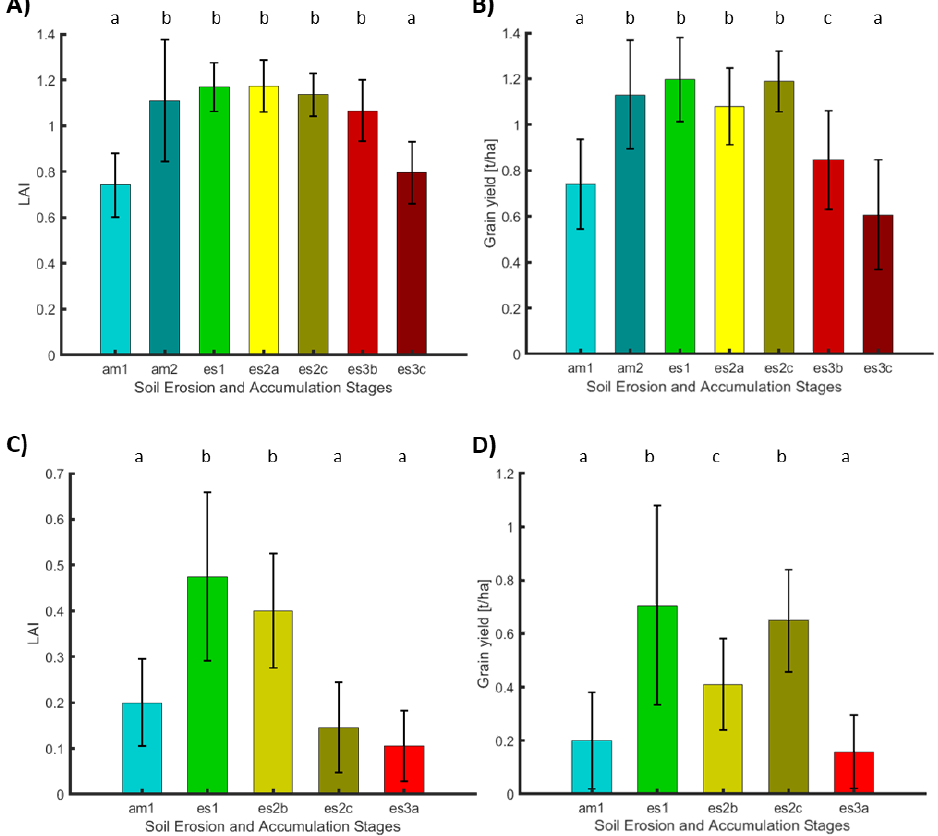
Figure 11. Median plots of biophysical parameters grouped across SEAS for field site SU (top row): ( A ) LAI and ( B ) grain yield, and field site E1 (second row): ( C ) LAI and ( D ) grain yield. Different letters on top of bars indicate significant statistical differences of parameters at 5% probability level between SEAS and same letters show no significant differences according to Kruskal – Wallis testing. Whiskers indicate the IQR of the parameter distribution.